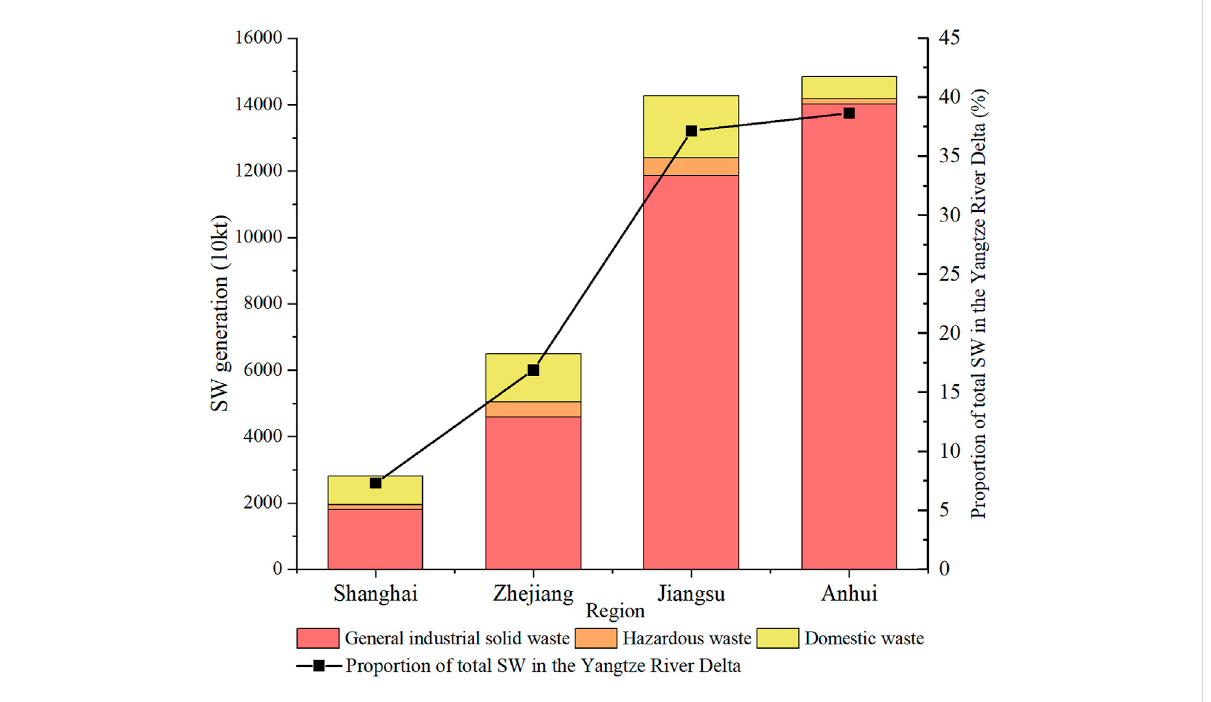
FIGURE 1 Municipal solid waste generation in different provinces or municipalities in the Yangtze River Delta in 2020.